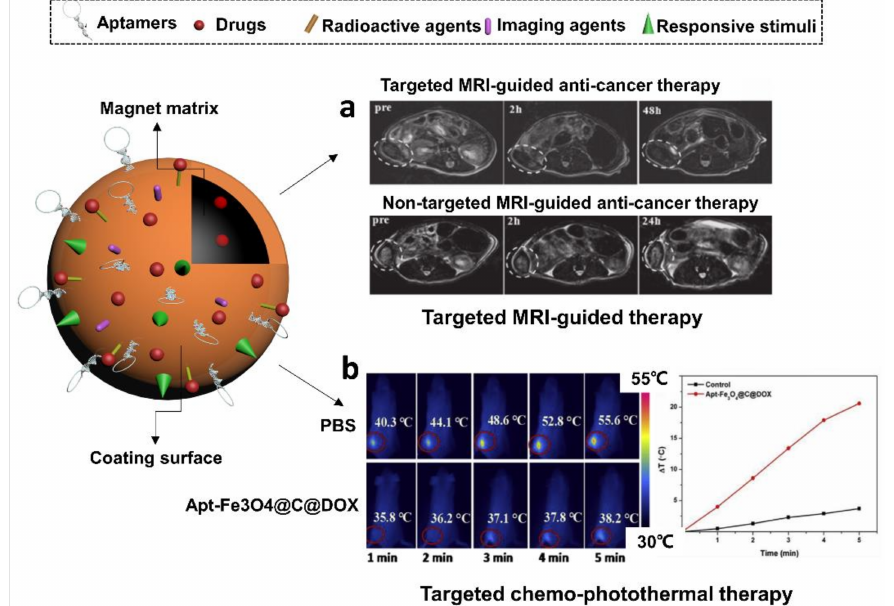
Figure 8. Schematic illustration of aptamer-functionalized magnetic nanomaterials. They have been used to ( a ) monitor the specific MRI-guided anti-prostate cancer therapy via DOX and ( b ) perform synergistic anti-cancer therapy mediated by DOX and hyperthermia in the guidance of MR imaging. ( a ) is adapted from reference [155]. Copyright 2011 Wiley Online Library. ( b ) is modified with permission of reference [157]. Copyright 2019